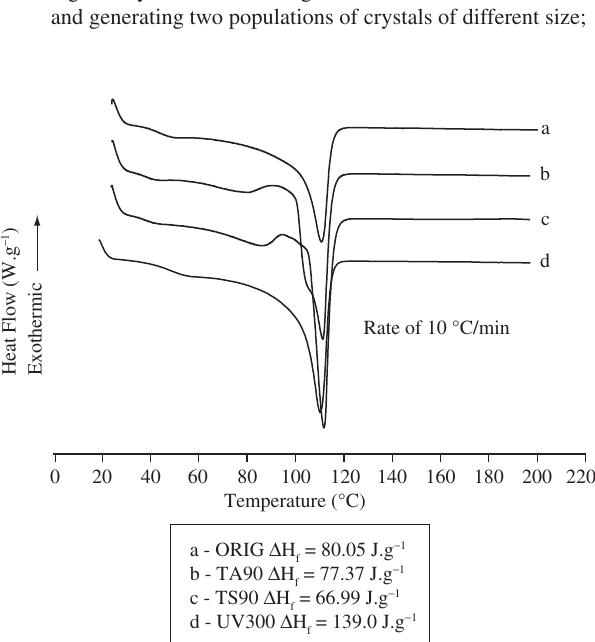
Figure 4. DSC thermogram for the LDPE BR sample.